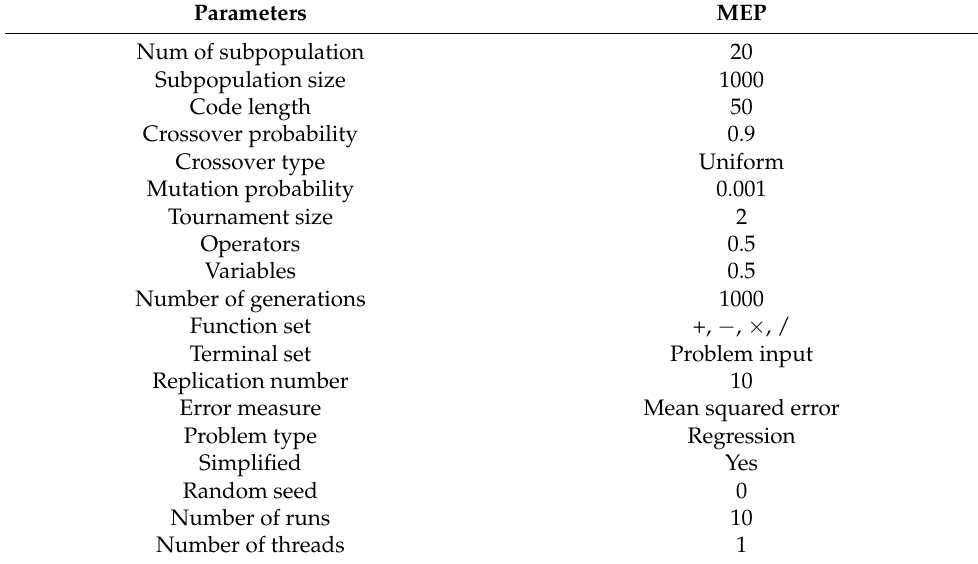
Table 3. MEP parameter used in making a model.